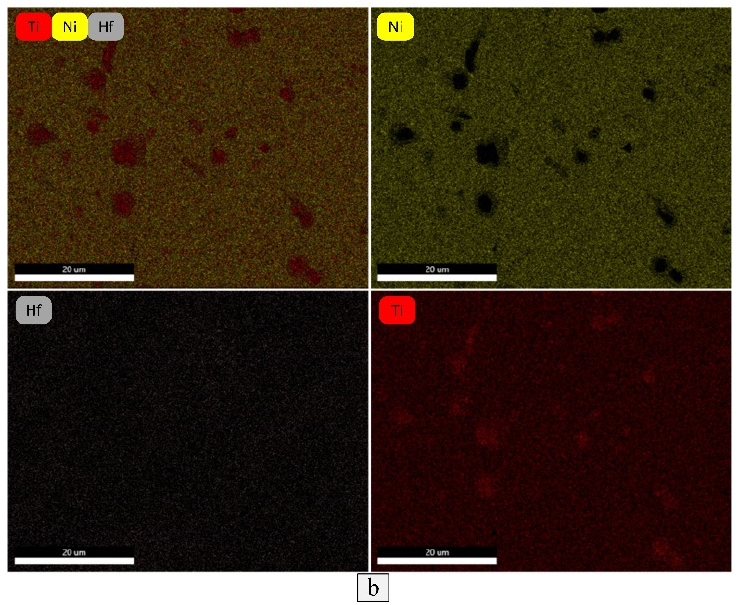
Figure 6. Elemental EDS mapping of Ti, Ni and Hf in TiNiHf rods after RF ( a ) and with higher resolution ( b ).